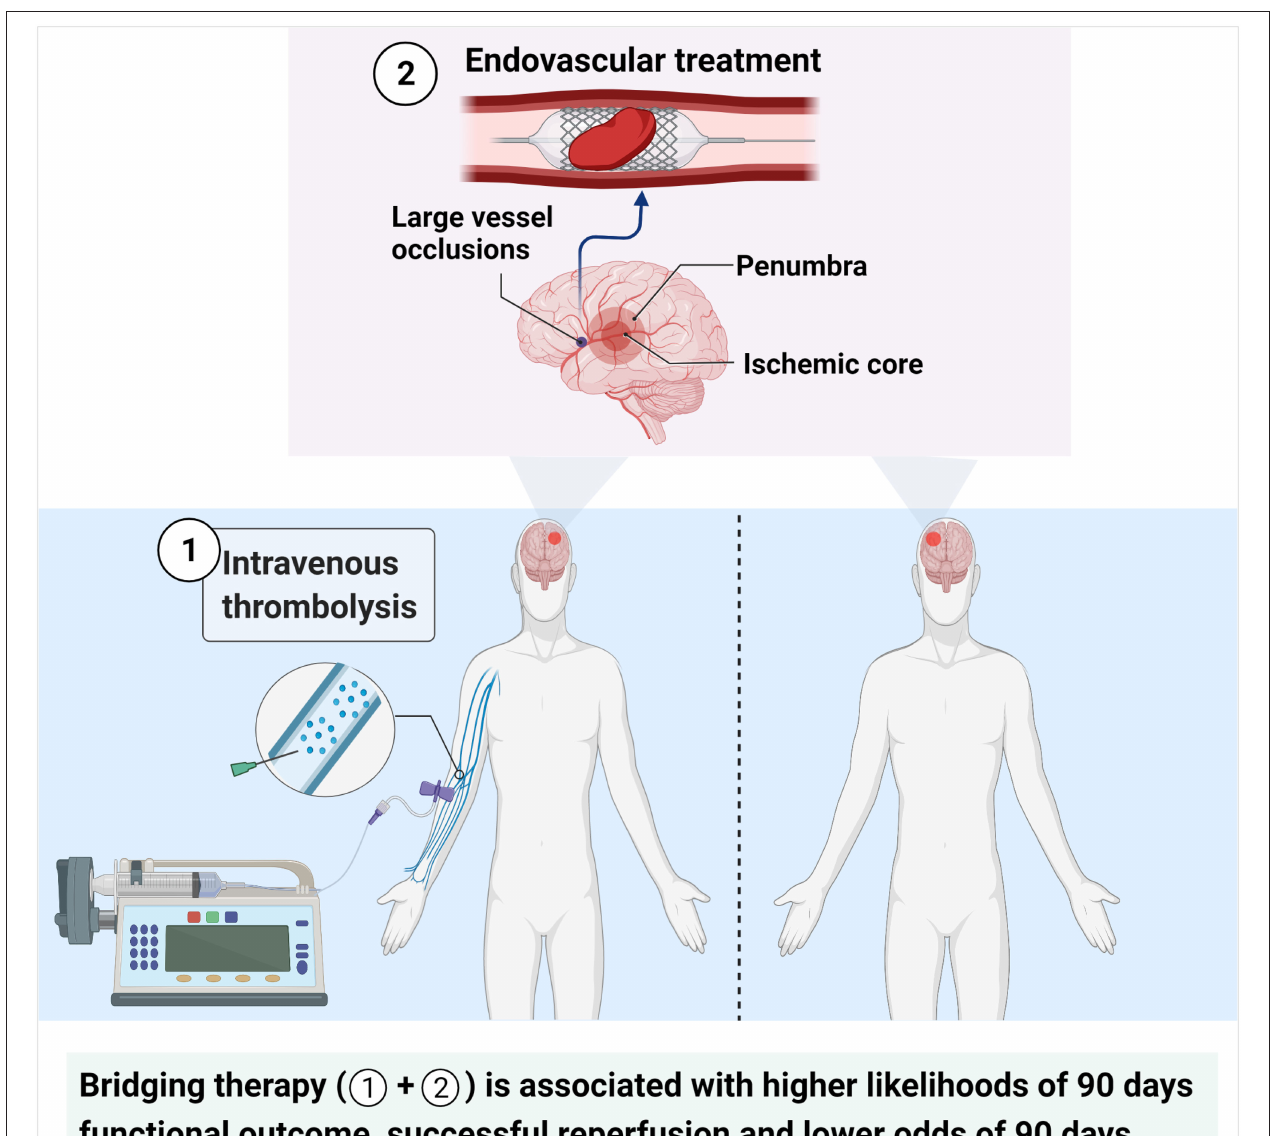
FIGURE 8 | The graphical abstract showing the conclusion in the